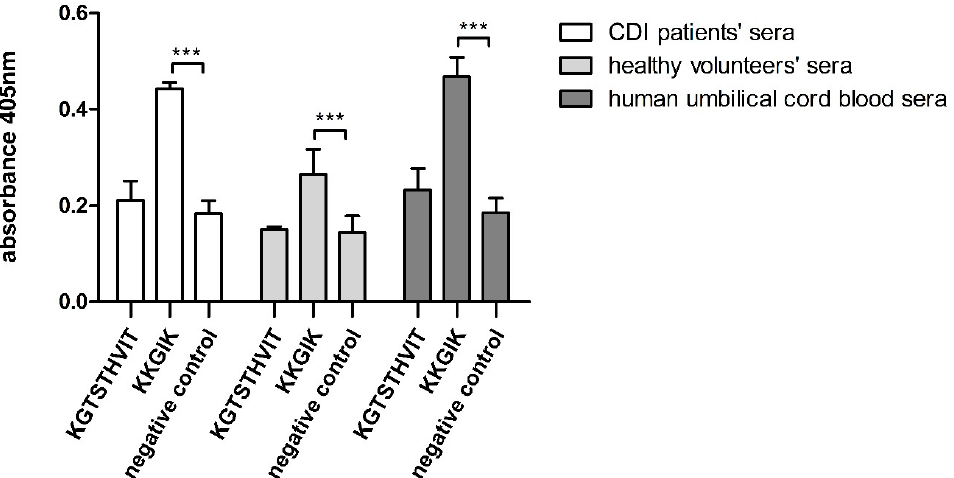
Figure 7. Immunoreactivity analysis of epitopes synthesized in a free form. Streptavidin-coated plates were coated with biotinylated peptides in carbonate buffer (pH = 9.5) in a concentration of 10 µ g / mL. ELISA was performed using CDI patients’ sera, healthy volunteers’ sera or human cord blood sera (dilution 1:1000), secondary antibodies anti-human IgG conjugated with AP, and AP Yellow Substrate was used for color reaction. Assay performed in triplicate. Data are shown with mean and ± SD. 2-way ANOVA and Bonferroni posttest were performed. All differences were statistically significant (*** p ≤